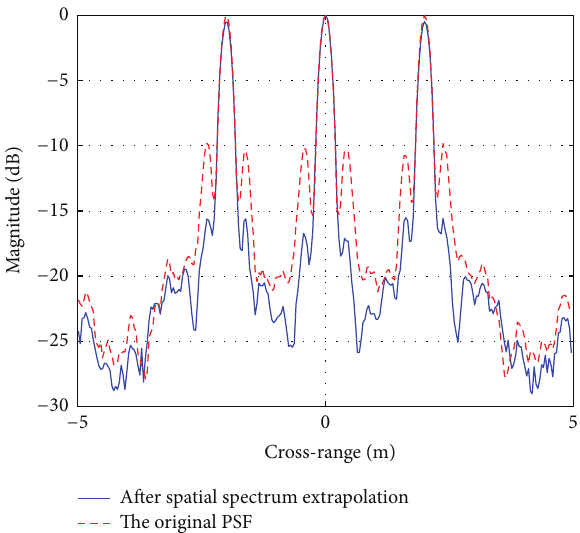
Figure 13: The sidelobes are suppressed by the proposed method. The PSLR for each target decreased from − 10.0dB to − 15.9 dB, − 17.1dB, and − 15.9dB, respectively. The main lobes in this figure are all unchanged.